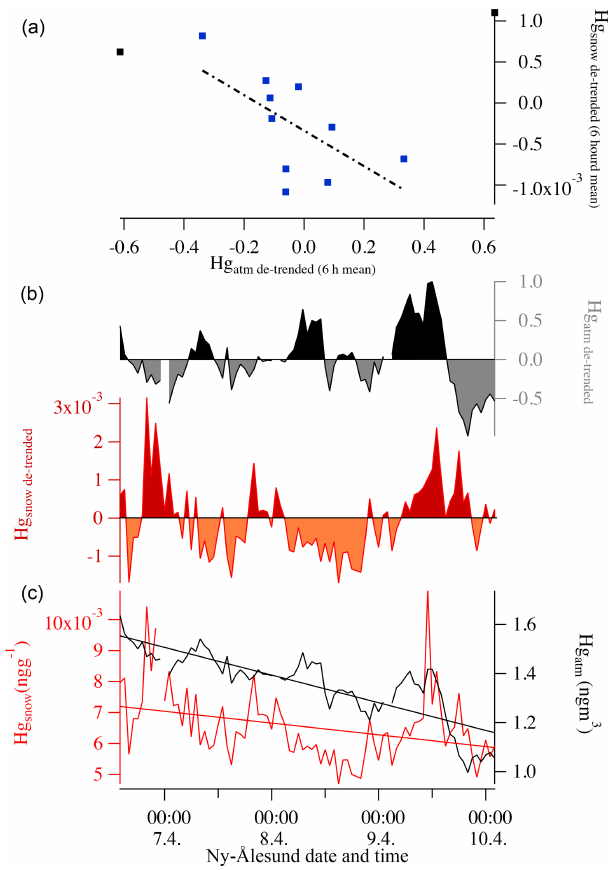
Figure 4. Panel (c) shows the two series without any statistical treat- ment (Hg atm – black; Hg snow – red). The regression line obtained for surface snow mercury is Hg snow − 0 . 0004 t + 16 . 136, while for atmospheric mercury, it is GEM = − 0 . 1127 t + 4787 . 8. Panel (b) shows the de-trended Hg series in surface snow (in red and orange) and atmosphere (grey and black). Panel (a) shows the correlation between de-trended Hg snow and Hg atm considering a 6h average value. The figure is based on the same data as Fig.